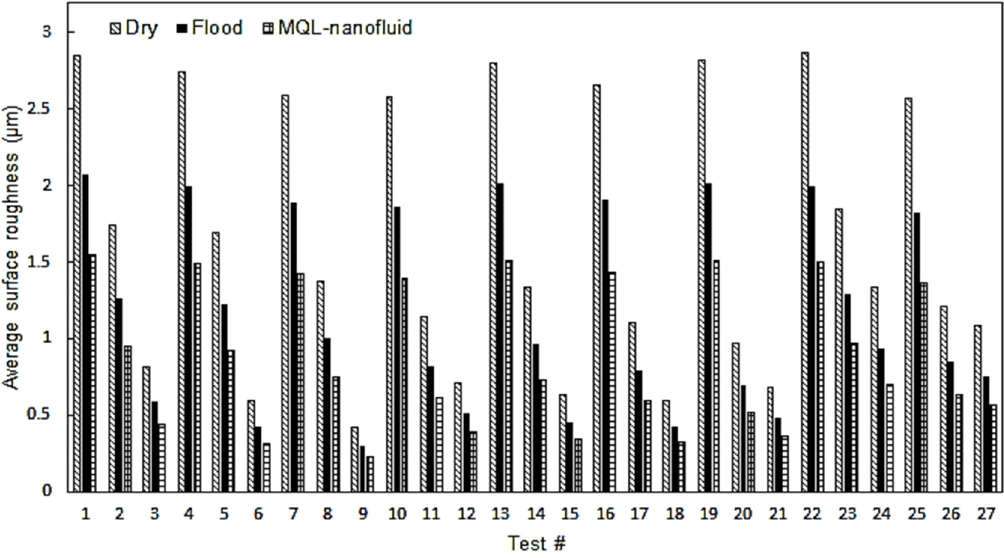
Figure 5. The surface roughness results.